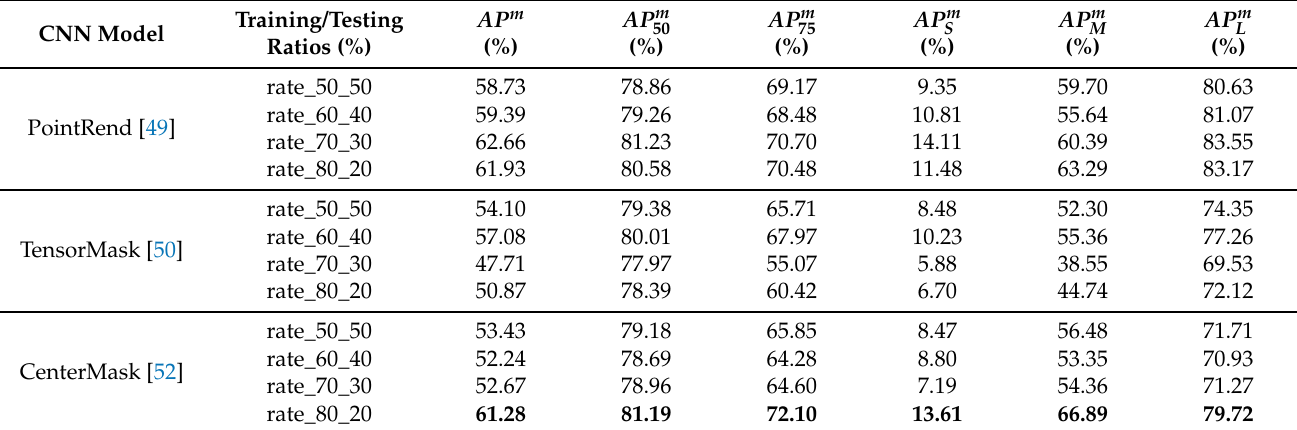
Table 10. The results (%—percent) of human segmentation (mask- m ) on the MADS dataset evaluated on the CNNs. CNN